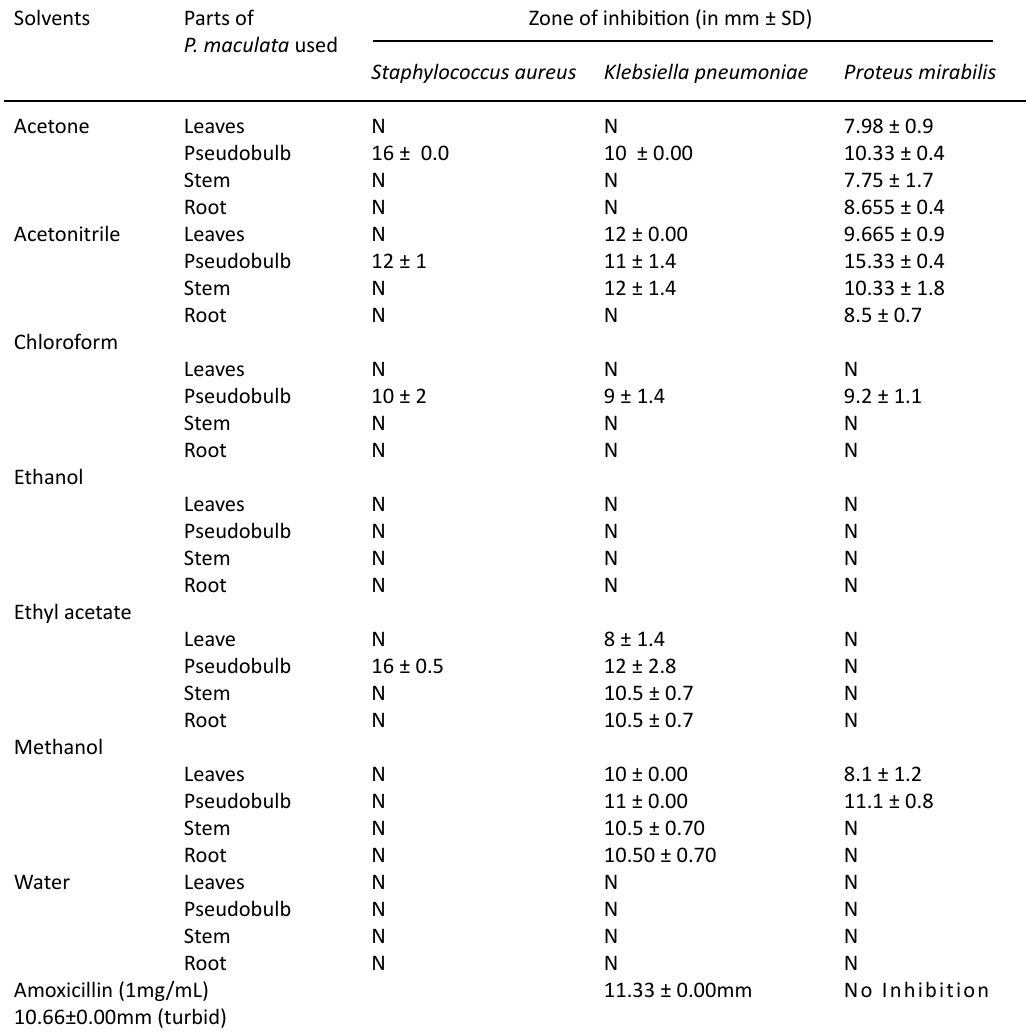
table 7. Antibacterial screening of different parts of P. maculata against some clinical isolates